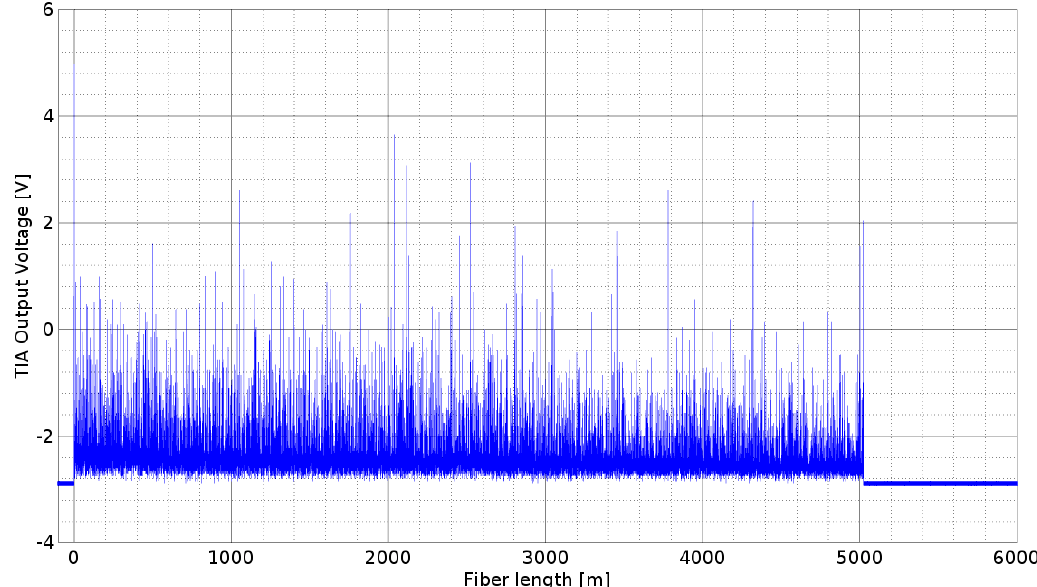
Figure 8. TIA output of a 5-km (about 5003 m) long coil fiber with an extra 20-m fiber used for the measurement. The trace time variable on the x-axis is converted to fiber length through Equation (15).